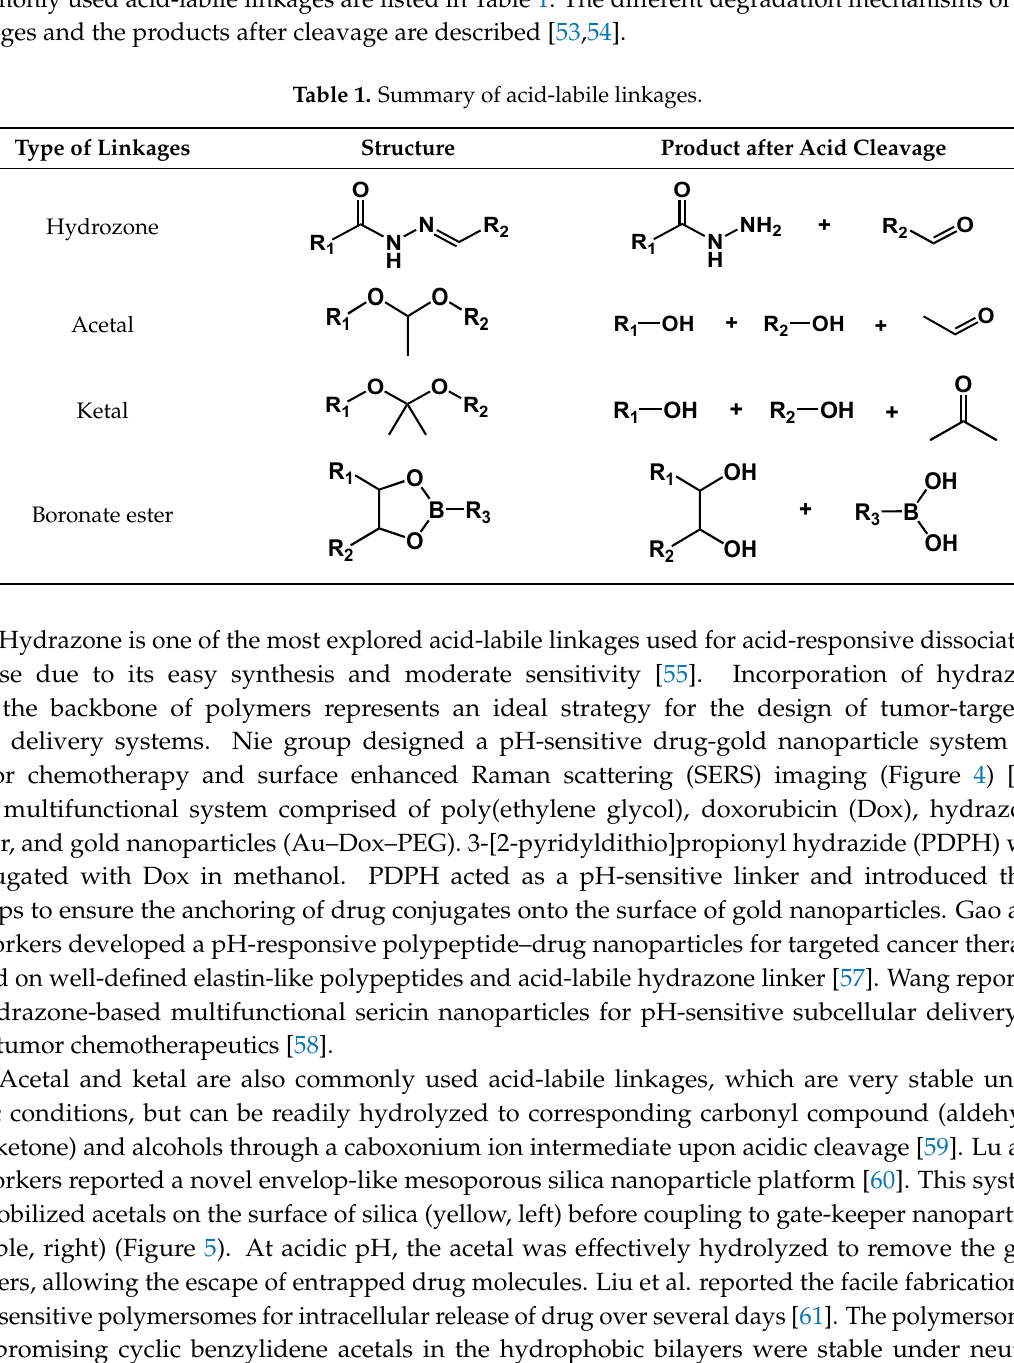
Figure 3 . Structures of pH-sensitive modified hyaluronic acid derivatives. Reproduced with